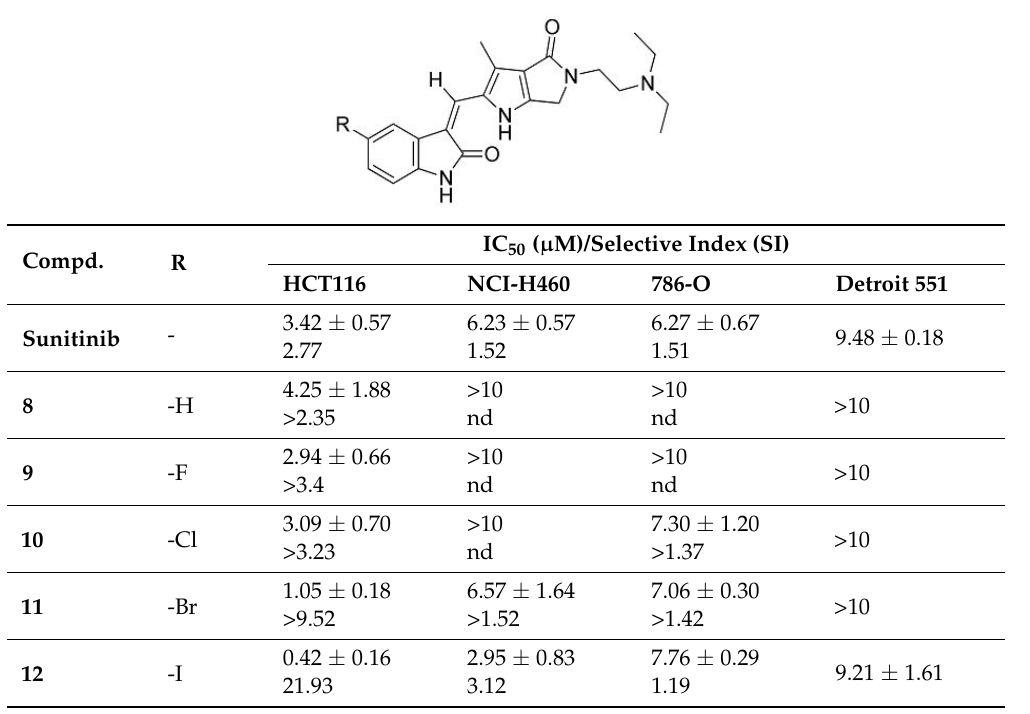
Table 1. Cellular activities and selective indexes of 8 – 12 and